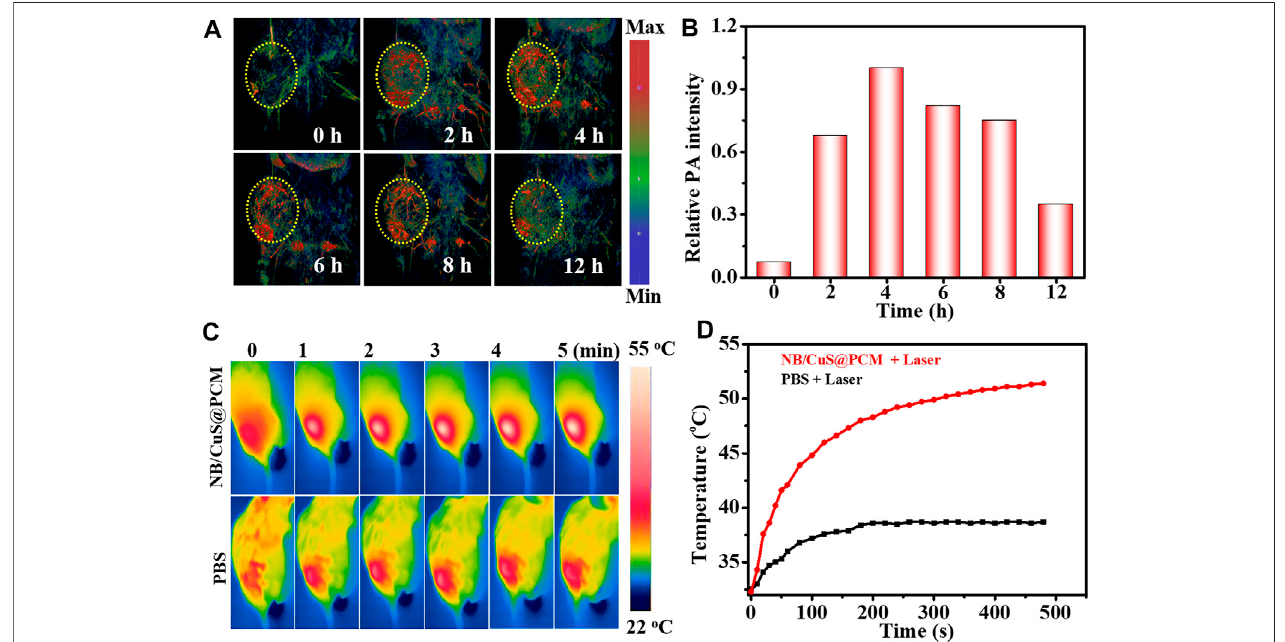
FIGURE 5 | (A) Change of tumor volume after intravenous injection of NPs or PBS with and without NIR light exposure. (B) Weight fl uctuation of mice during the treatment. (C) Histopathological analysis of tumor tissue by H&E staining after 1 day of treatment.